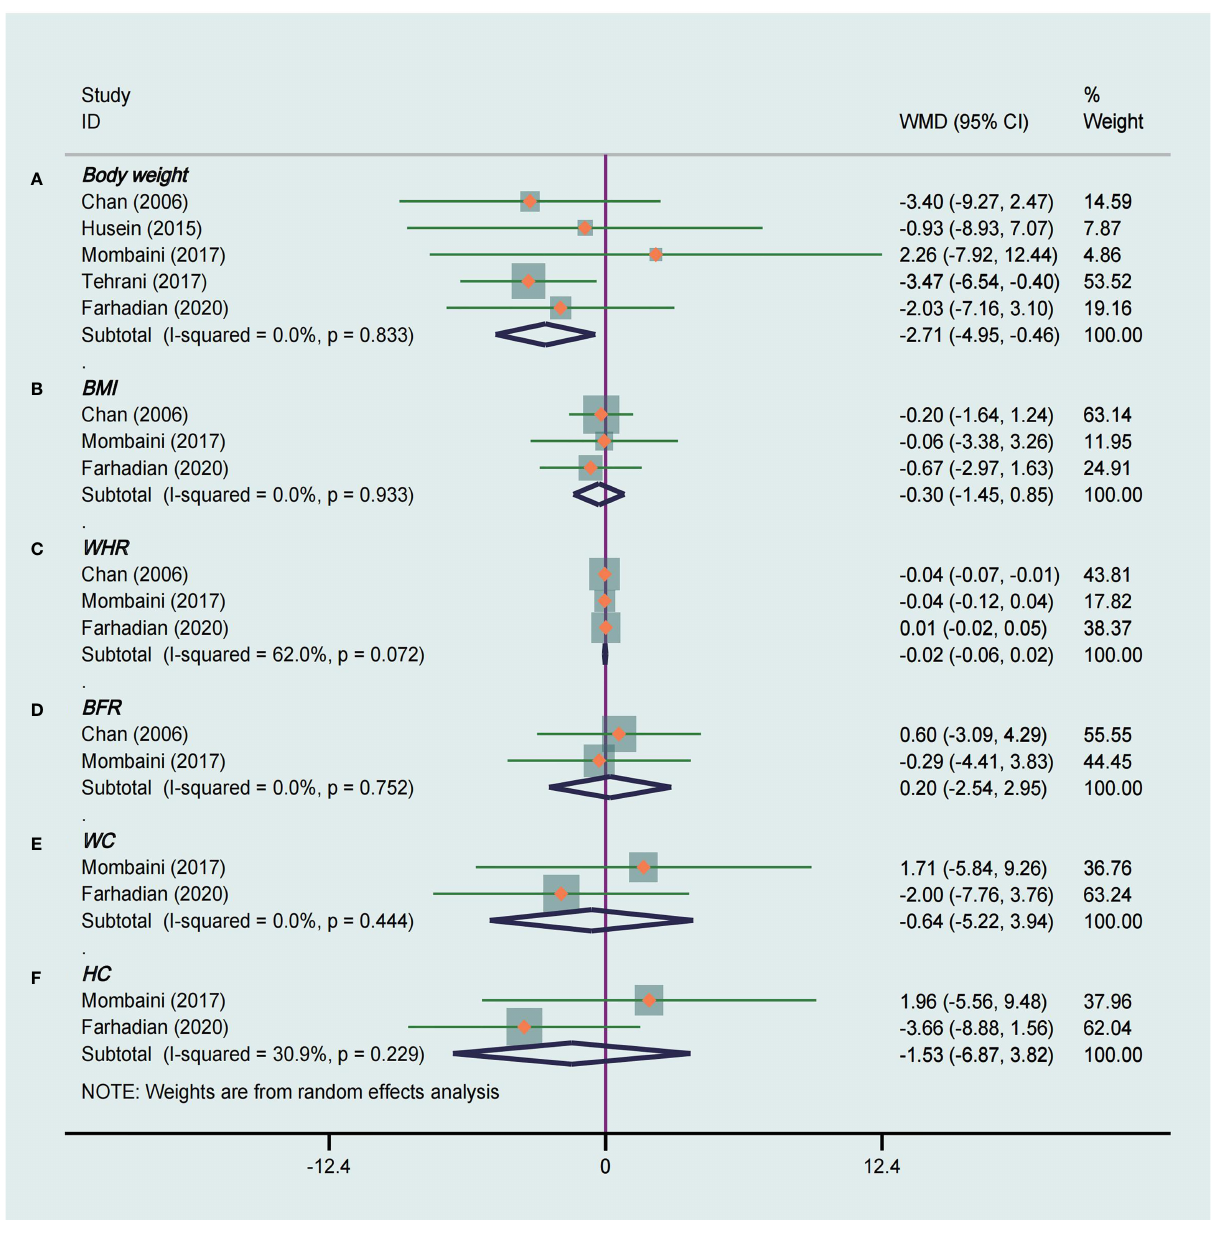
Frontiers in Endocrinology |